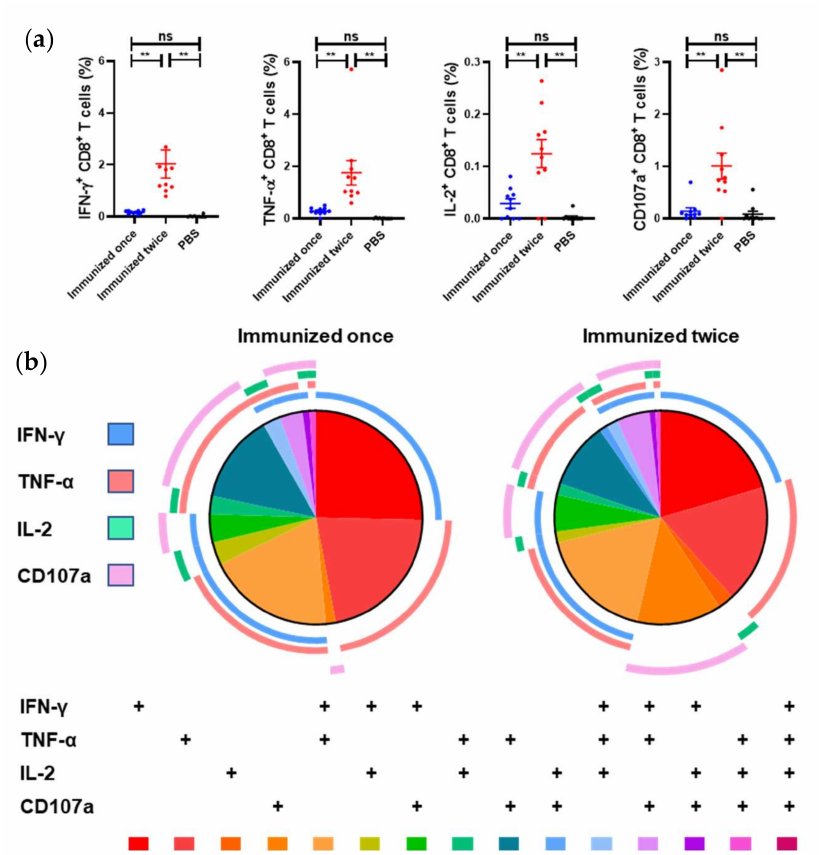
Figure 5. LASV GPC–specific CD8 + T-cell polyfunctionality response elicited by Ad5-GPC LASV . BALB/c mice ( n = 10 per group) were immunized intramuscularly with a dose of 10 7 PFU of Ad5- GPC LASV once on day 0, or twice, on days 0 and 28. The murine splenocytes were collected on days 14 and day 42. ( a ) The CD8 + T cell-mediated immune responses were assessed by multiparameter intracellular cytokine staining. ( b ) SPICE plots were generated to demonstrate the fraction of LASV GPC-specific CD8 + T cells that were producing each immune marker in response to GL-9. Pie wedge colors refer to the legend below, whereas pie arc colors refer to the legend on the left. Abbreviations: IFN- γ , interferon γ ; IL-2, interleukin 2; TNF- α , tumor necrosis factor α ; CD107a, cluster of differentiation 107a. Data are presented as mean ± SEM, and statistical significance was determined by one way ANOVA and Turkey’s multiple comparison test (** p <